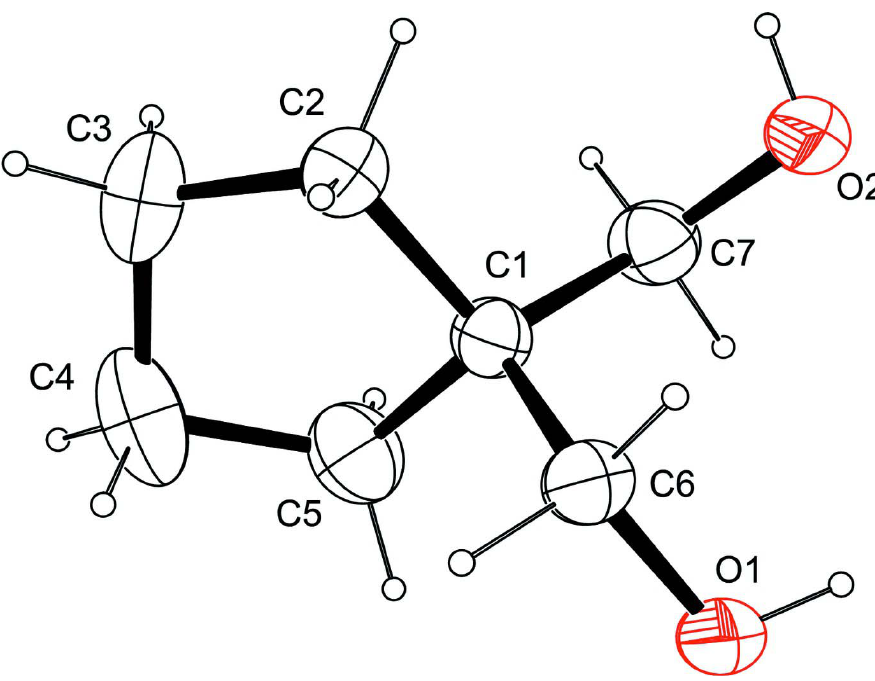
Figure 1 The molecular structure of the title compound, with atom labels and anisotropic displacement ellipsoids (drawn at 50% probability level) for non-H atoms.